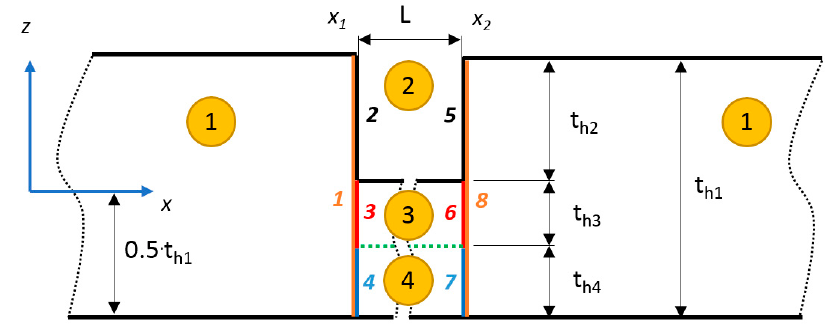
Figure 2. Scattering of Lamb wave at the vertical notch of width L.